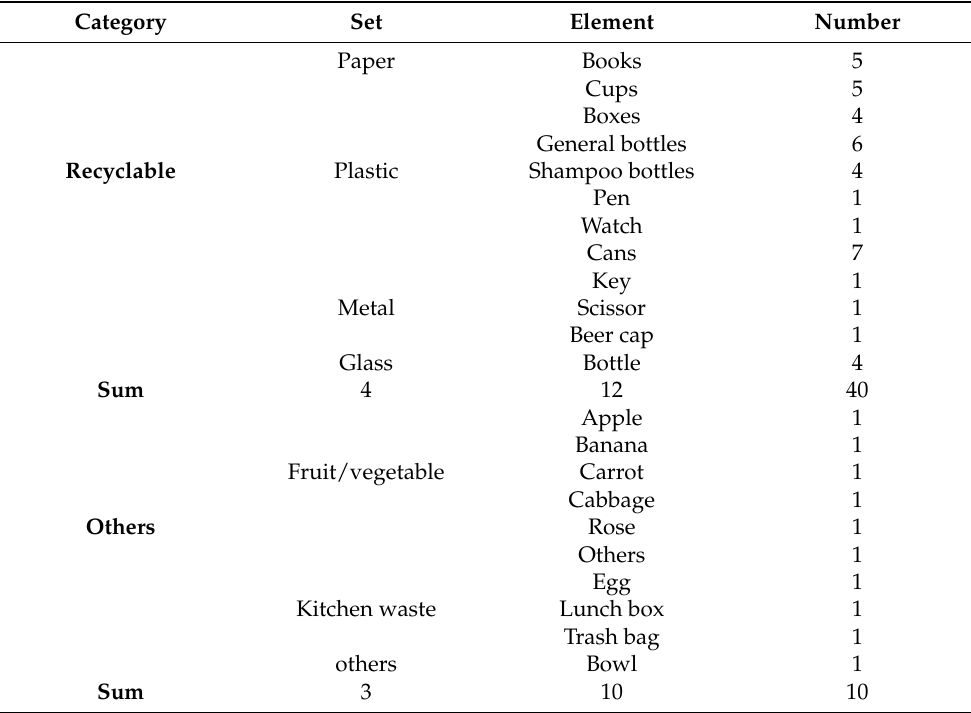
Table 10. Categorization of waste materials using the proposed